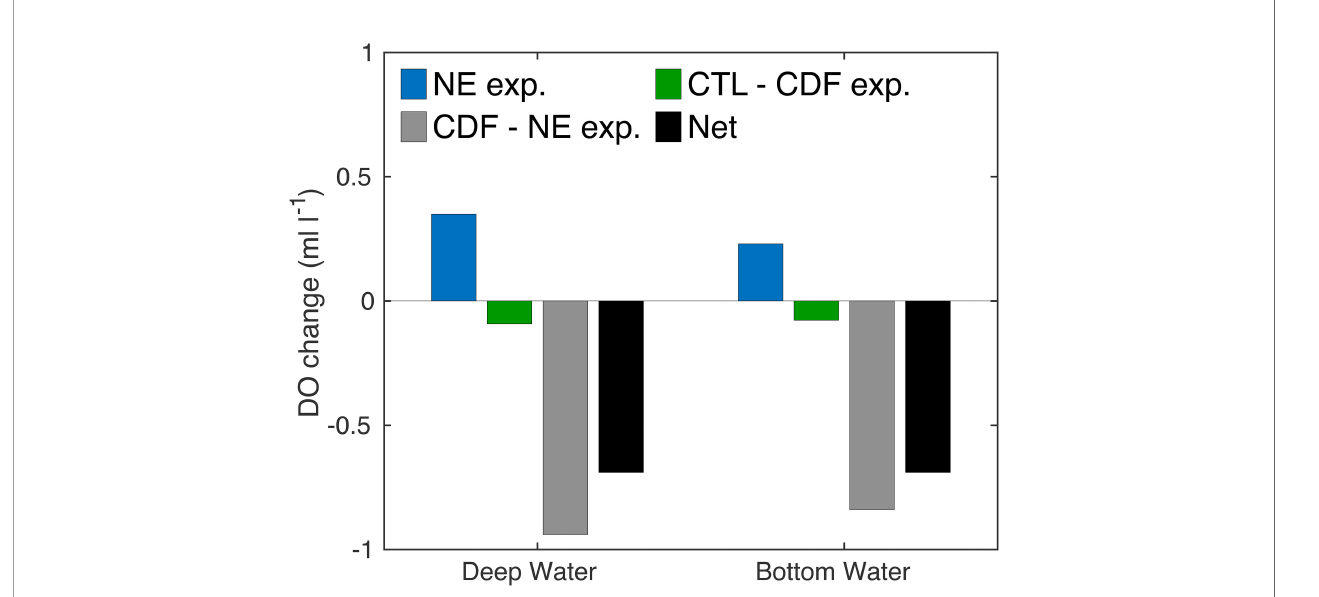
FIGURE 11 | Changes in the dissolved oxygen (DO) concentration over the 36-year period (1980 to 2015) at each depth range from 1618 to 2250 m (deep water) and 2250 m to the bottom (bottom water). Blue, green, and gray bars indicate the DO change of the no-ecosystem (NE) experiment, the difference between the control (CTL) and constant detritus fl ux (CDF) experiments, the difference between the CDF and the NE experiments, respectively. The black bar indicates the net change in the DO concentration.